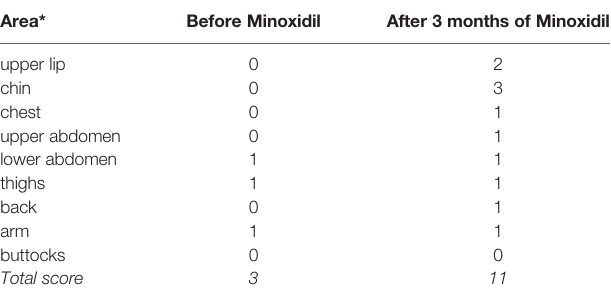
TABLE 2 | Modi fi ed Ferriman-Gallwey score evaluation before and after 3 months of minoxidil monotherapy. Area* Before Minoxidil After 3 months of Minoxidil